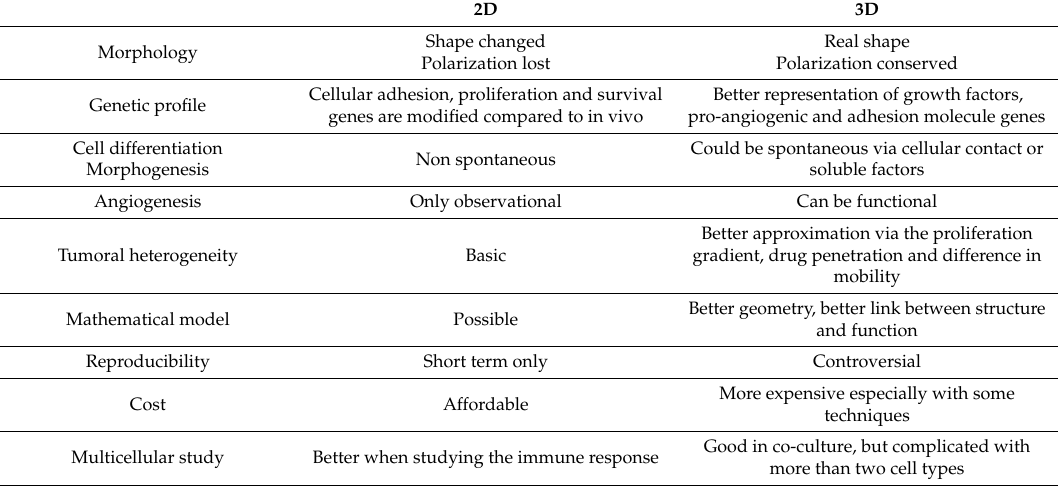
Table 1. Main differences between 2D and 3D when studying tumor microenvironment interactions. 2D 3D Shape changed Real shape Morphology Polarization lost Polarization conserved Cellular adhesion, proliferation and survival Better representation of growth factors, Genetic profile genes are modified compared to in vivo pro-angiogenic and adhesion molecule genes Cell differentiation Could be spontaneous via cellular contact or Non spontaneous Morphogenesis soluble factors Angiogenesis Only observational Can be functional Better approximation via the proliferation Tumoral heterogeneity Basic gradient, drug penetration and difference in mobility Better geometry, better link between structure Mathematical model Possible and function Reproducibility Short term only Controversial More expensive especially with some Cost Affordable techniques Multicellular study Better when studying the immune